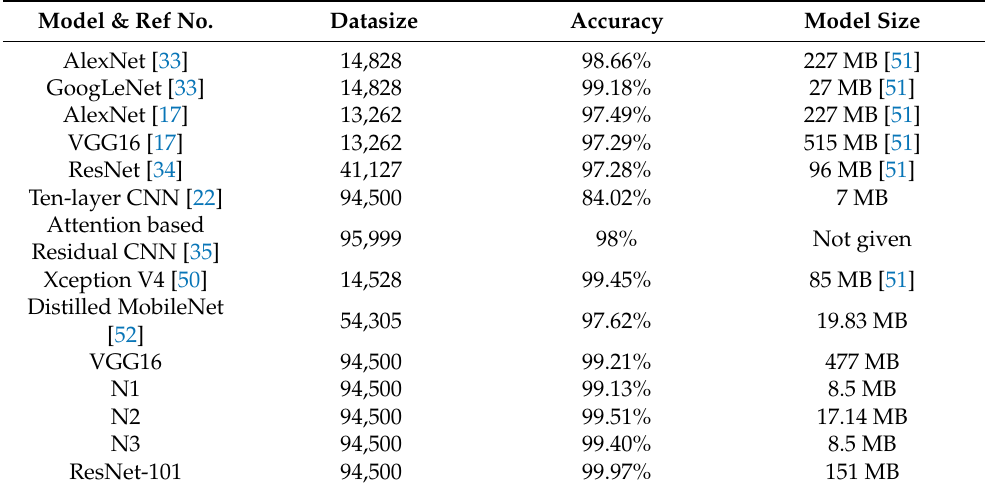
Table 4. Performance comparison of proposed work in comparison to other existing works. Model & Ref No.